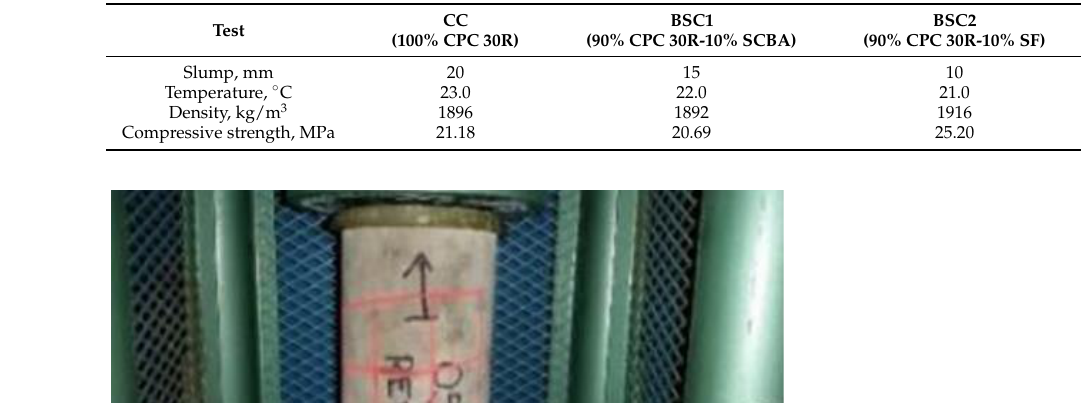
Table 4. Physical properties conventional concrete and binary sustainable concretes.